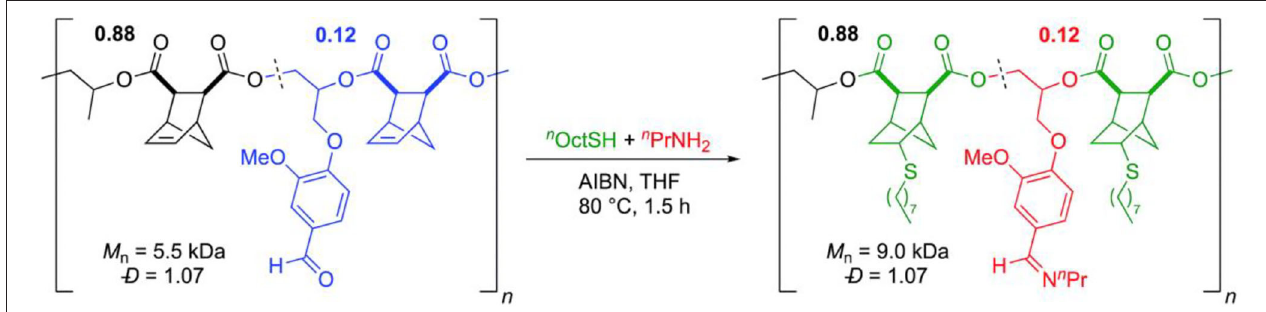
FIGURE 12 | Orthogonal, one-pot, double post-polymerization modification reaction. Adapted with permission from Sanford et al. (2018). Copyright 2018 The Royal Society of Chemistry.